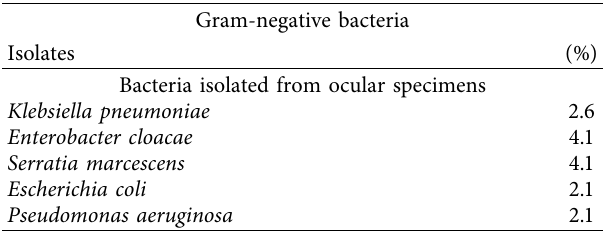
Table 3: Prevalence of Gram-negative bacteria isolated from ocular specimens.